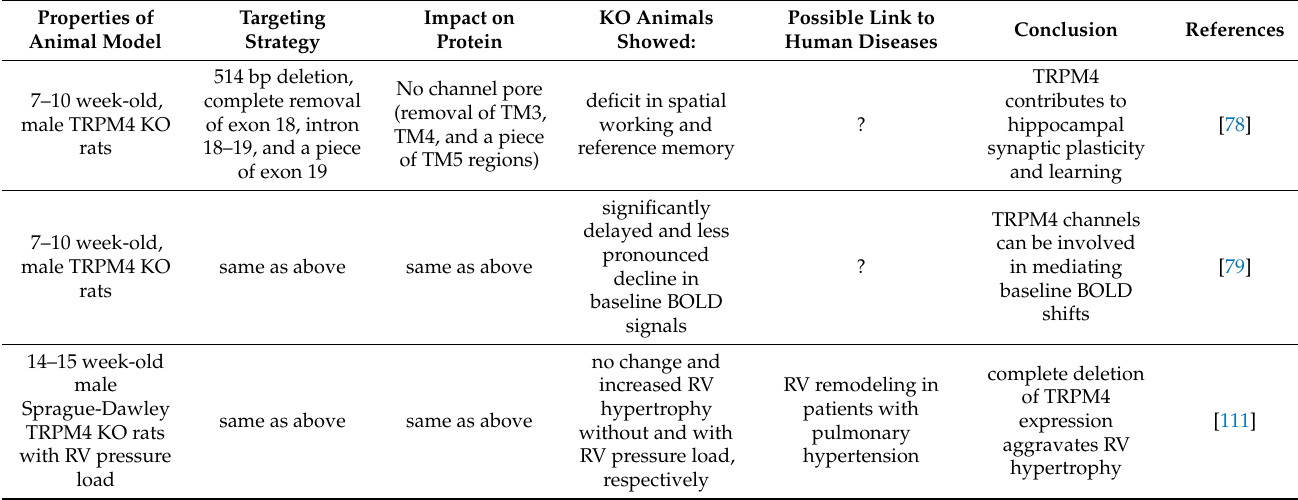
Table 2. Summary of rat TRPM4 KO animal